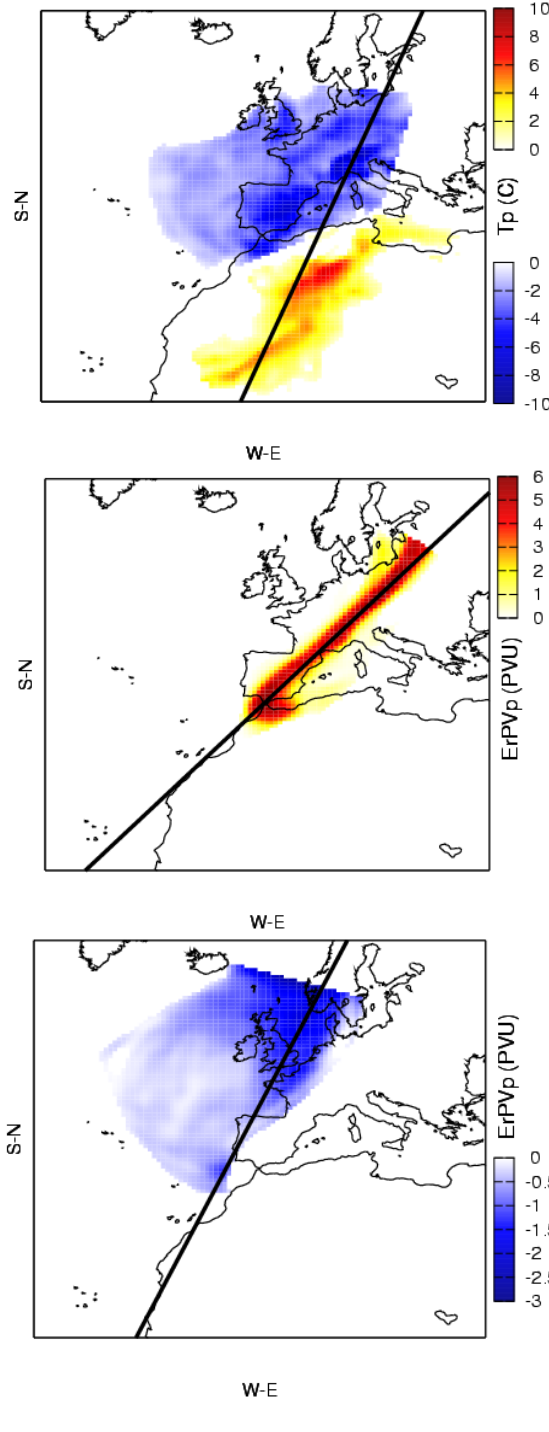
Fig. 6. Surface thermal anomaly defined as ErPVpTerm (top; yellow-red, positive values; white-blue, negative values), Upper level PV perturbation (300hPa) related to upper level trough de- fined as ErPVp01 (middle), Upper level PV perturbation (300hPa) related to North Atlantic High defined as ErPVpHigh (bottom), dif- ferent scales are used. Solid lines show different vertical cross sec-